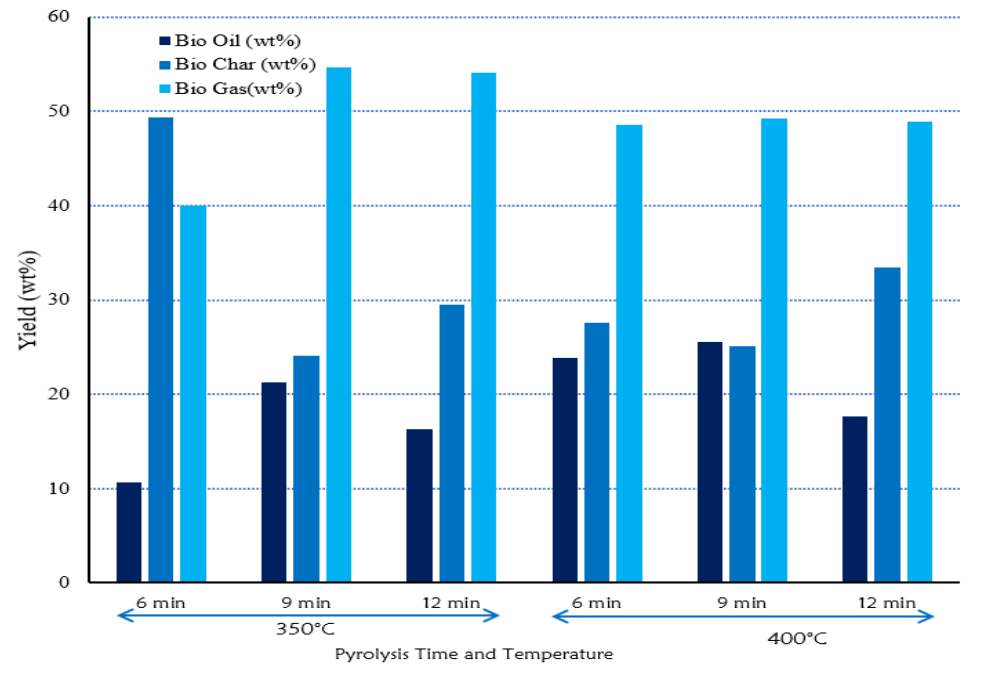
Figure 4: Overall product yield of microwave-assisted